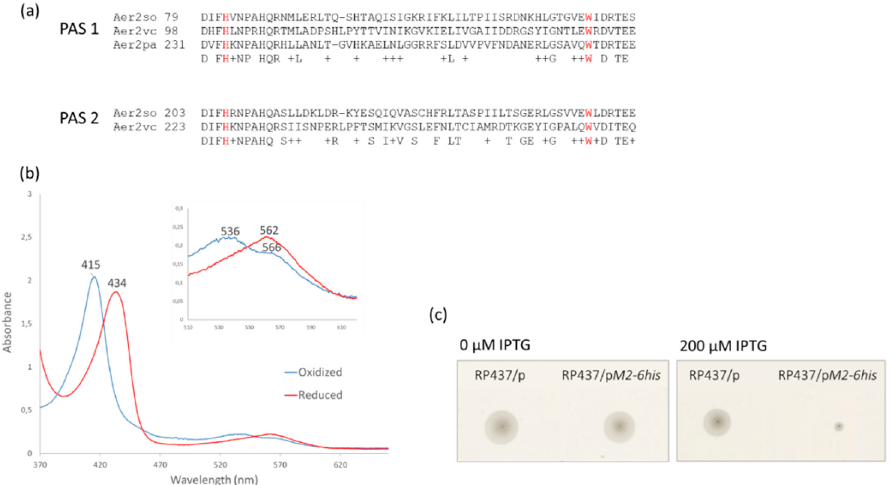
Figure 2. Aer2so characteristics. ( a ) Sequence alignment of Aer2 PAS domains of S. oneidensis , V. cholerae , and P. aeruginosa by Clustal Omega. The conserved histidine and tryptophan involved in heme coordination and O 2 -binding stabilization [48], respectively, are highlighted in red. “+” indicates similar amino acids. ( b ) Absorption spectra of purified Aer2so in the reduced and oxidized states. Aer2so was fully oxidized during purification and its reduction was obtained with dithionate. The wavelength for each absorbance maximum is indicated. An expanded view of peaks between 530 and 610 nm is shown in the inset. ( c ) Effect of Aer2so on E. coli chemotaxis. E. coli RP437 producing, or not producing, Aer2so-6his was inoculated in tryptone soft agar with 0 or 200 µ M IPTG. The plates shown are representative of at least three independent experiments.